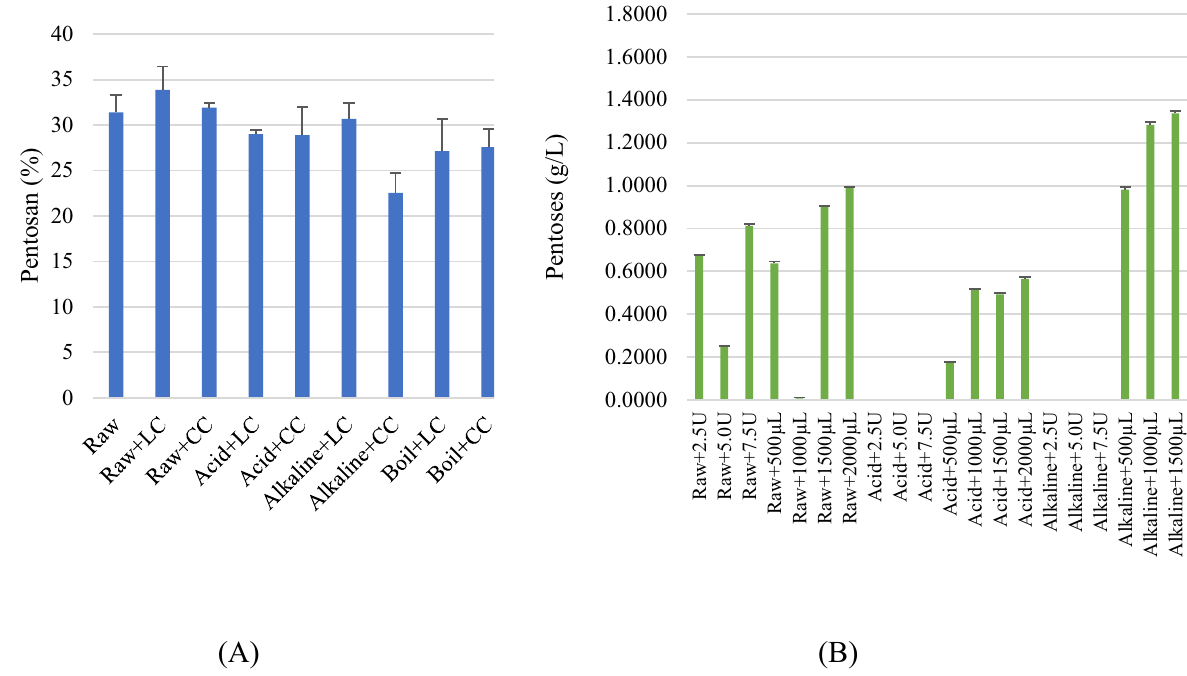
Figure 7. ( A ) Percentage of pentosan remaining in the pre-treated and hydrolysed rice straw. ( B ) Pentose production in the liquid digestate (LC is laboratory grade cellulase enzyme, CC is commercial grade cellulase enzyme).